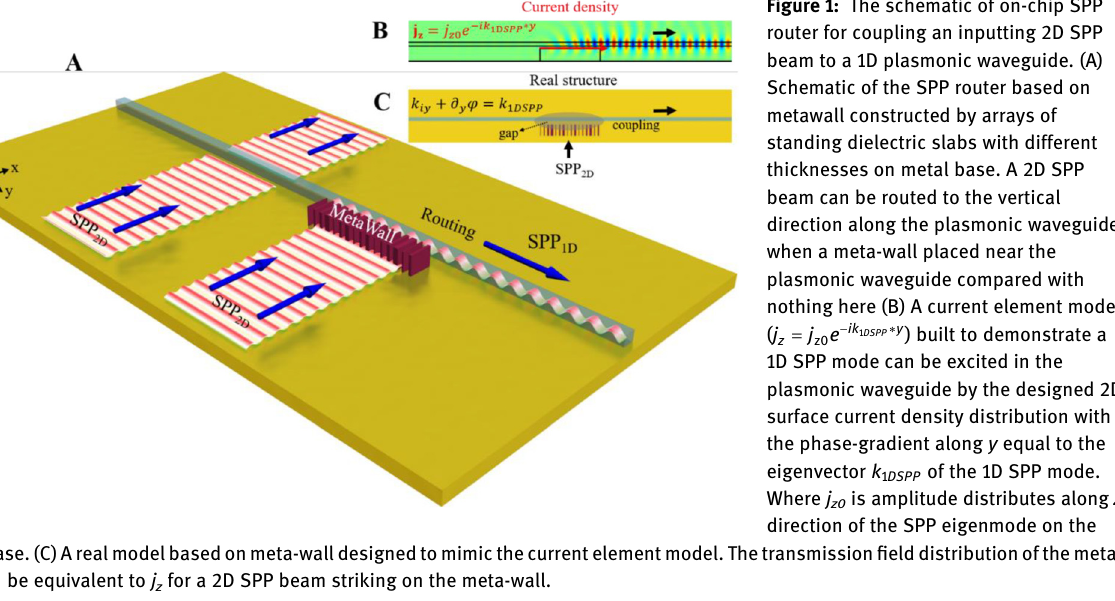
Figure 1: The schematic of on-chip